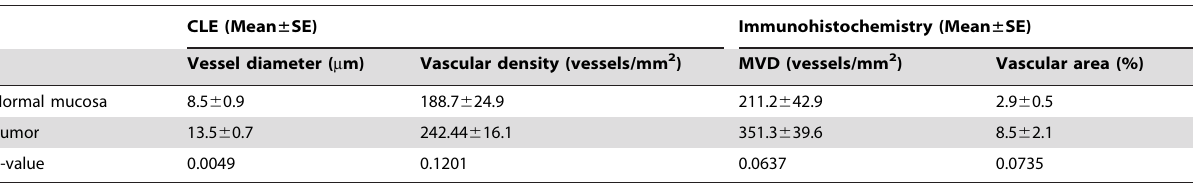
Table 1. The vascular parameters obtained with CLE and immunohistochemistry in normal mucosa and colorectal